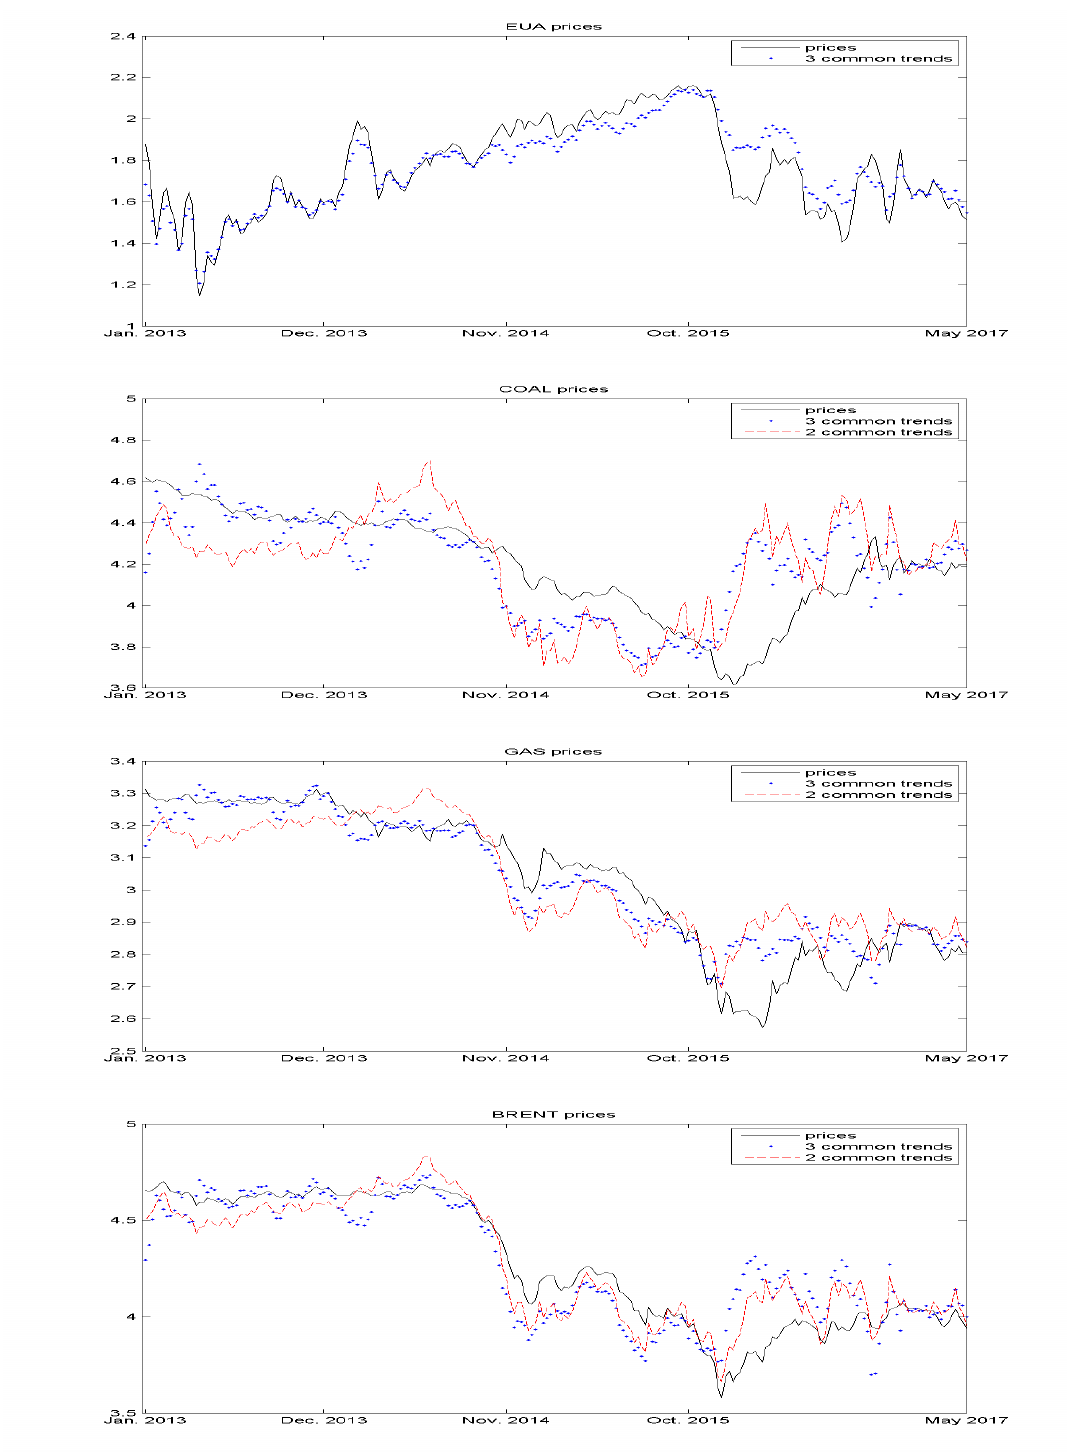
Figure 5. Permanent component A 1 f t in the decomposition (5) using the three and two common trends obtained from weekly data on Y t and (cid:101) Y t , respectively. The sample spans the period January 2013–May